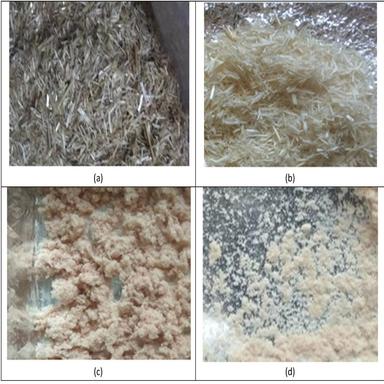
Images of wheat straw: (a) untreated, (b) bleached, (c) alkali treated and (d) nanocellulose.